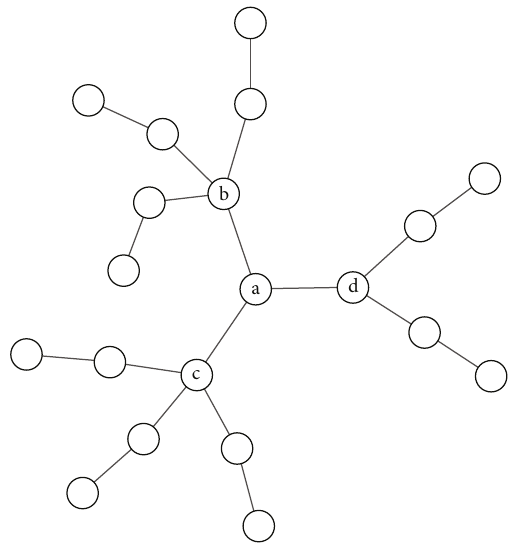
Figure 1: Toy network illustrating the nonnested centrality of node sets. The number of nodes reachable from nodes a , b , c , and d in two steps ( m = 2 ) equals 11, 9, 9, and 7, respectively. Thus, node a has the highest m -reach centrality in the network. Yet, from the ( a , d ) set of nodes only 12 and from the ( a , b ) or ( a , c ) set of nodes only 13, while from the ( b , c ) set of nodes, 14 other nodes are reachable in two steps. Thus, the ( b , c ) set is more central than the other sets, based on reachability. The highest centrality node ( a ) is not a subset of the highest centrality set of two nodes ( b , c